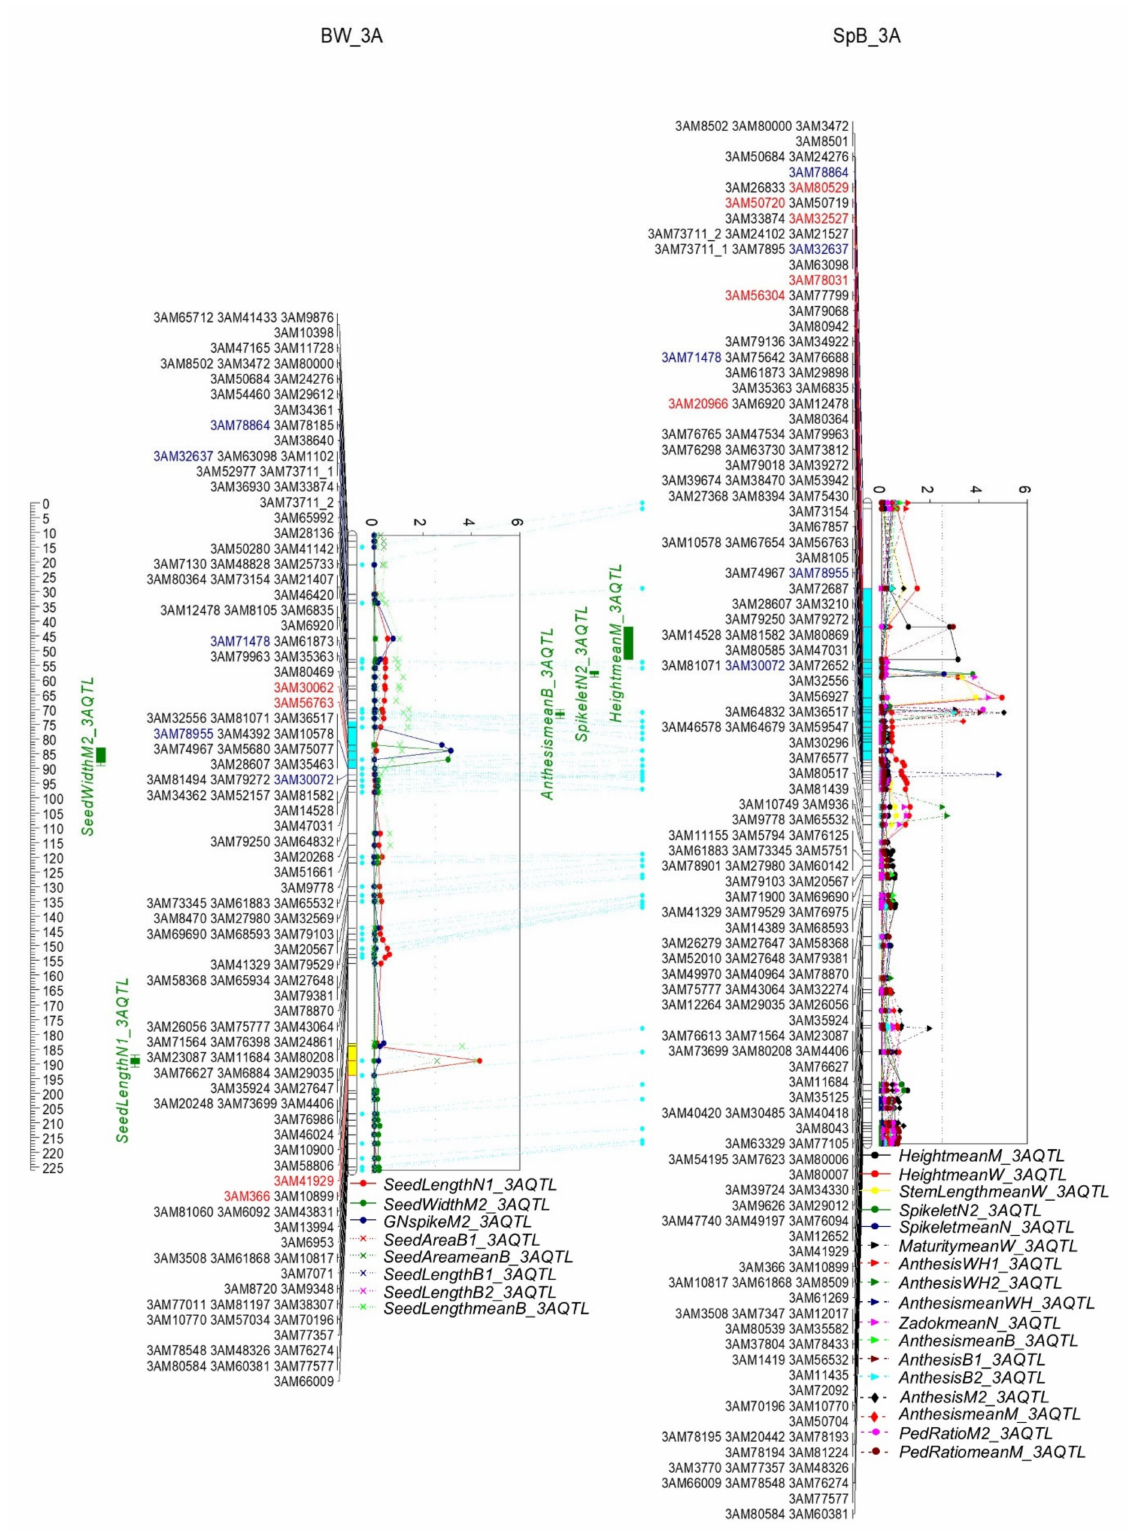
Figure 8. Significant QTL formed two QTL clusters on 3A—one on the homologous region on 3A—in both populations, BW and SpB. Homologous regions in both populations are highlighted in light blue; the QTL cluster on one population is highlighted in yellow; markers for QTL are highlighted in red; homologous markers are highlighted in blue. Two QTL clusters were detected on 3B, one for each population (Figure S9 and Table S6). One QTL (3B.1) cluster was identified between 3BM71944 and 3BM1239 (102.2–135.5